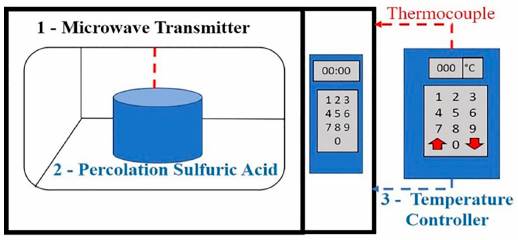
Figure 4. Schematic drawing of the microwave apparatus and temperature controller. Where: 1 Microwave transmitter; 2 percolation of sulfuric acid in the iron ore particles; 3 temperature controller.